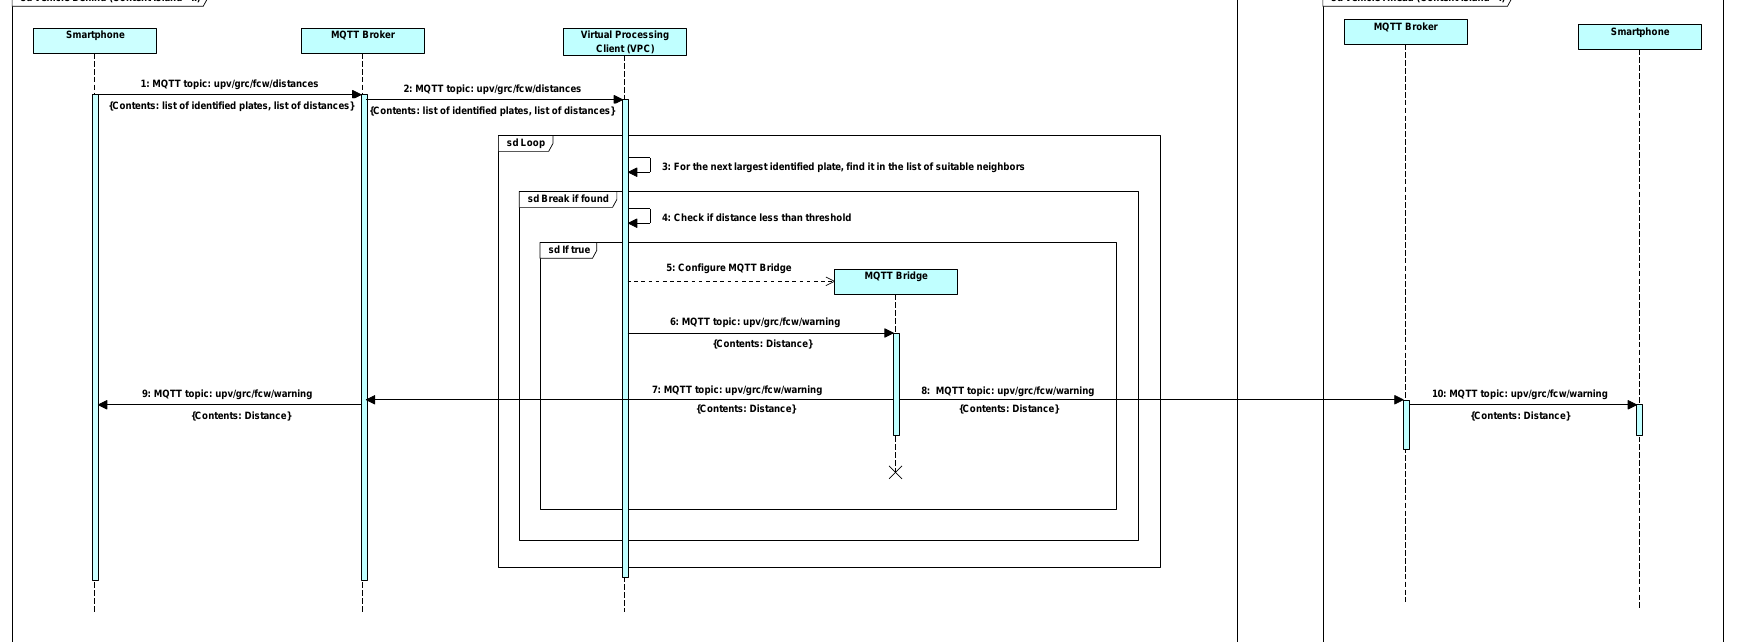
Figure 5. Sequence diagram of warning generation once distance estimation is